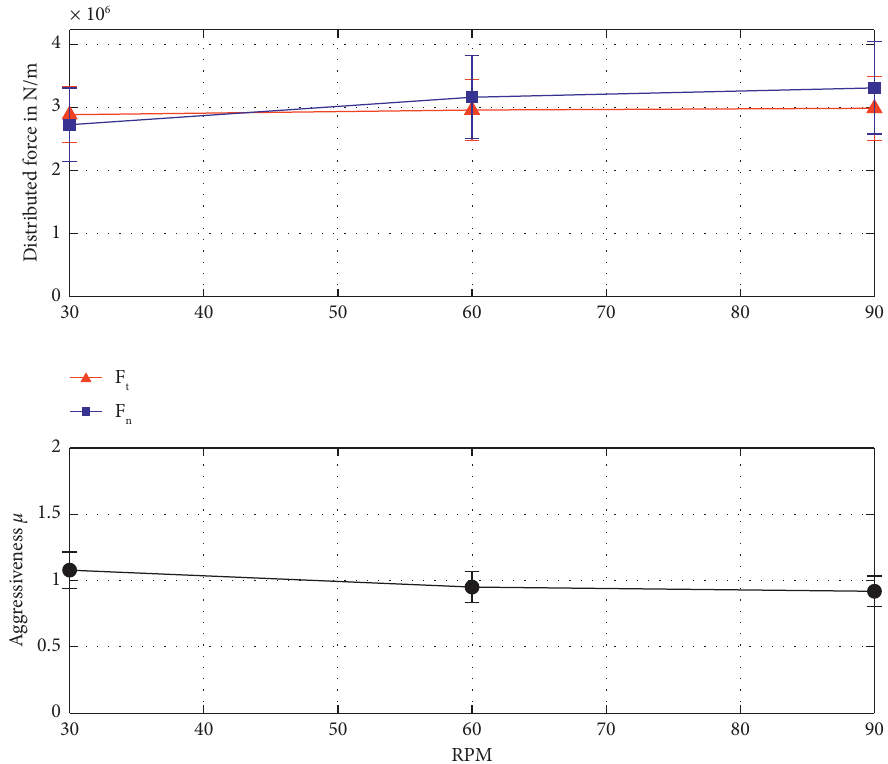
Figure 9: Averaged forces and aggressiveness at various cutting speeds using the model with rate-dependent normal bond